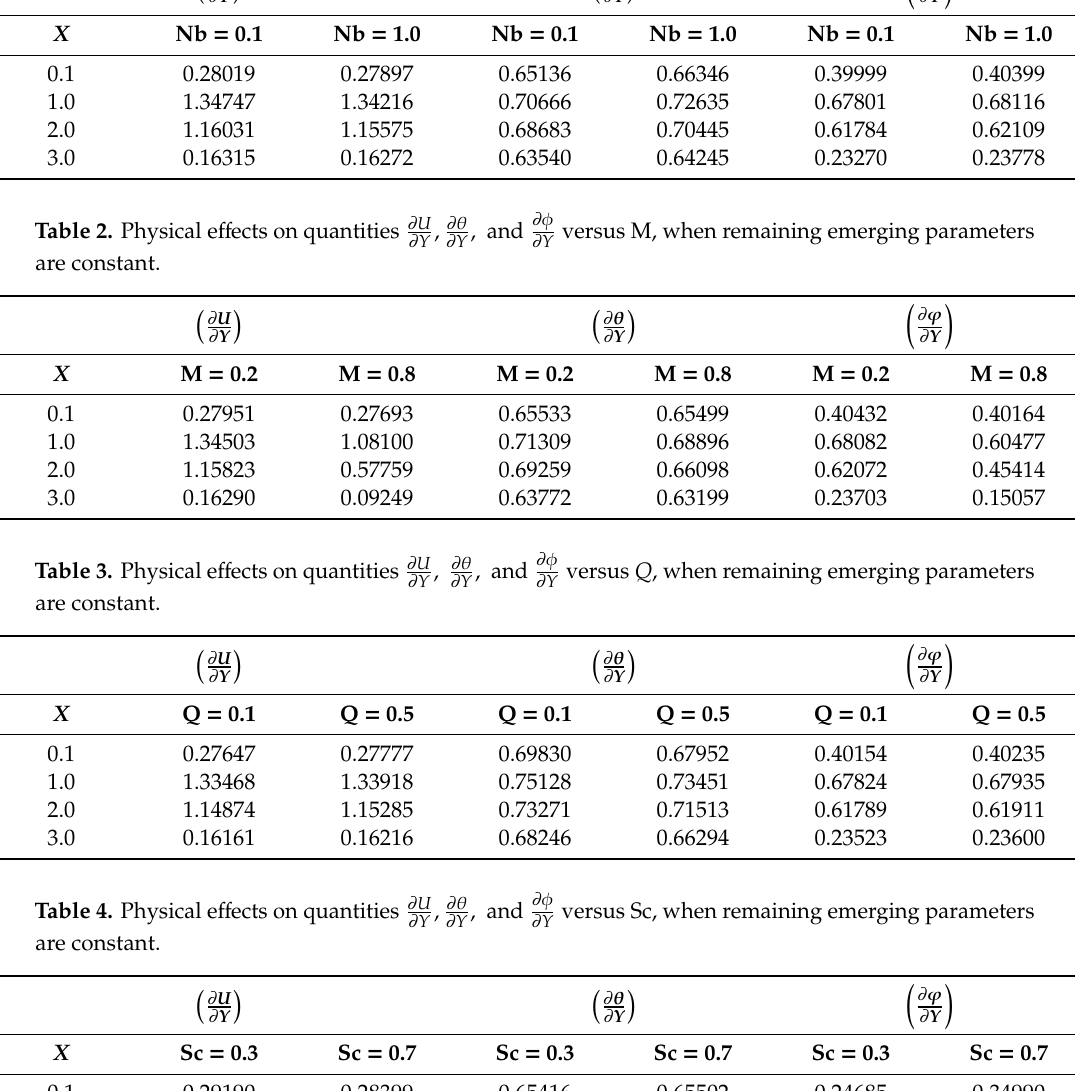
∂φ ∂θ , ∂ Y , and ∂ Y versus Nb, when remaining emerging parameters Y